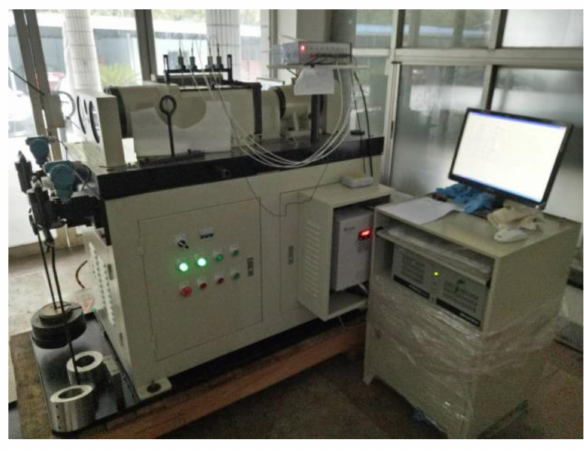
Figure 7. The ABLT-1A bearing fatigue testing